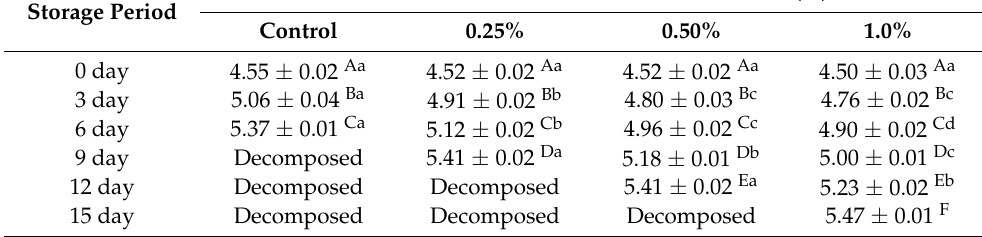
Table 10. Pattern of mold and yeast counts (log10 cfu/g) in minced beef treated with ethanolic Cassia glauca leaf extracts (0.25%, 0.5%, 1%) during the cold storage period at 3 ± 1 ◦ C (mean ± standard deviation